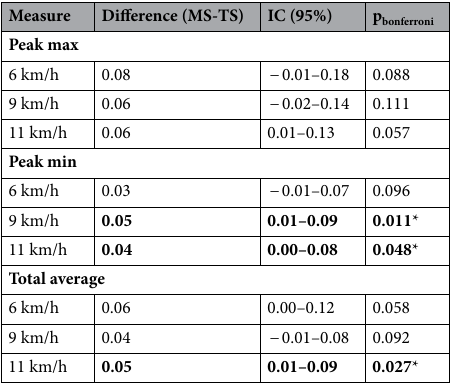
Table 3. Effects of shoes in electromyographic variables. *Bonferroni post-hoc test was used. Significant values are in bold.